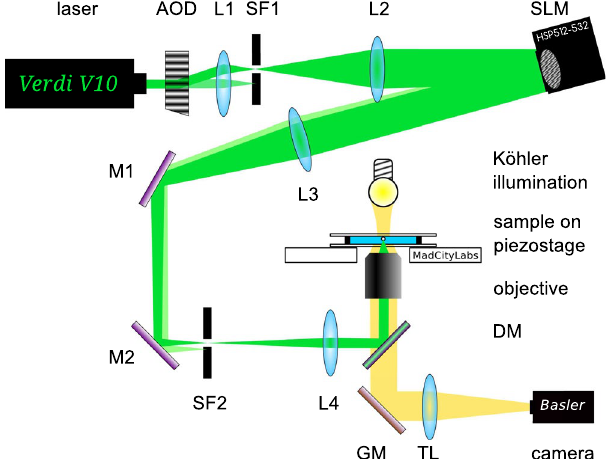
Figure 5. Experimental setup. Laser – Verdi V10 (Coherent, vacuum wavelength 532 nm), AOD – acousto- optical deflector R35085-3 (Gooch&Housego), lens L1 – AC254-050-A (f 1 = 50 mm, Thorlabs), spatial filter SF1 – high-power precision pinhole P25C ( φ 25 μ m, Thorlabs), lens L2 – AC254-300-A (f 2 = 300 mm, Thorlabs), SLM – spatial light modulator HSP512-532-PCIe (Meadowlark Optics), lens L3 – AC508-500-A (f 3 = 500 mm, Thorlabs), M1, M2 – broadband dielectric mirrors BB1-E02 (Thorlabs), spatial filter SF2 – iris aperture SM1D12D (Thorlabs), lens L4 – AC254-150-A (Thorlabs), DM - dichroic mirror (made in-house), objective – PlanC N 40x/0.65 (Olympus), combined motorized microstage and piezo-driven nanostage –